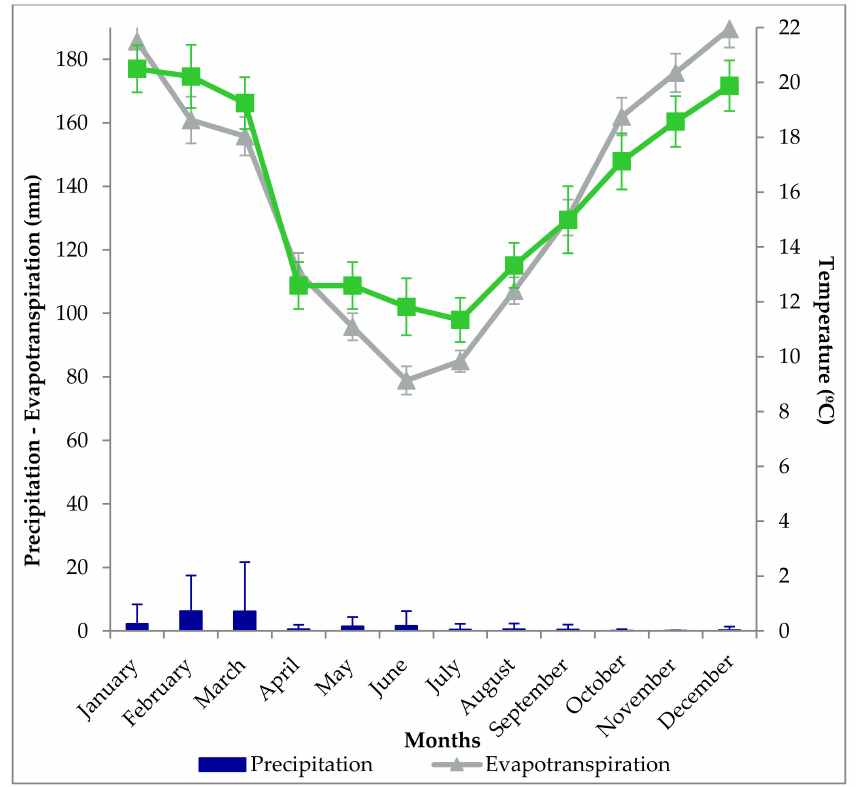
Figure 3. Average monthly precipitation (mm), evapotranspiration (mm) and temperature ( ◦ C) for the period 1975–2016 for Peine meteorological